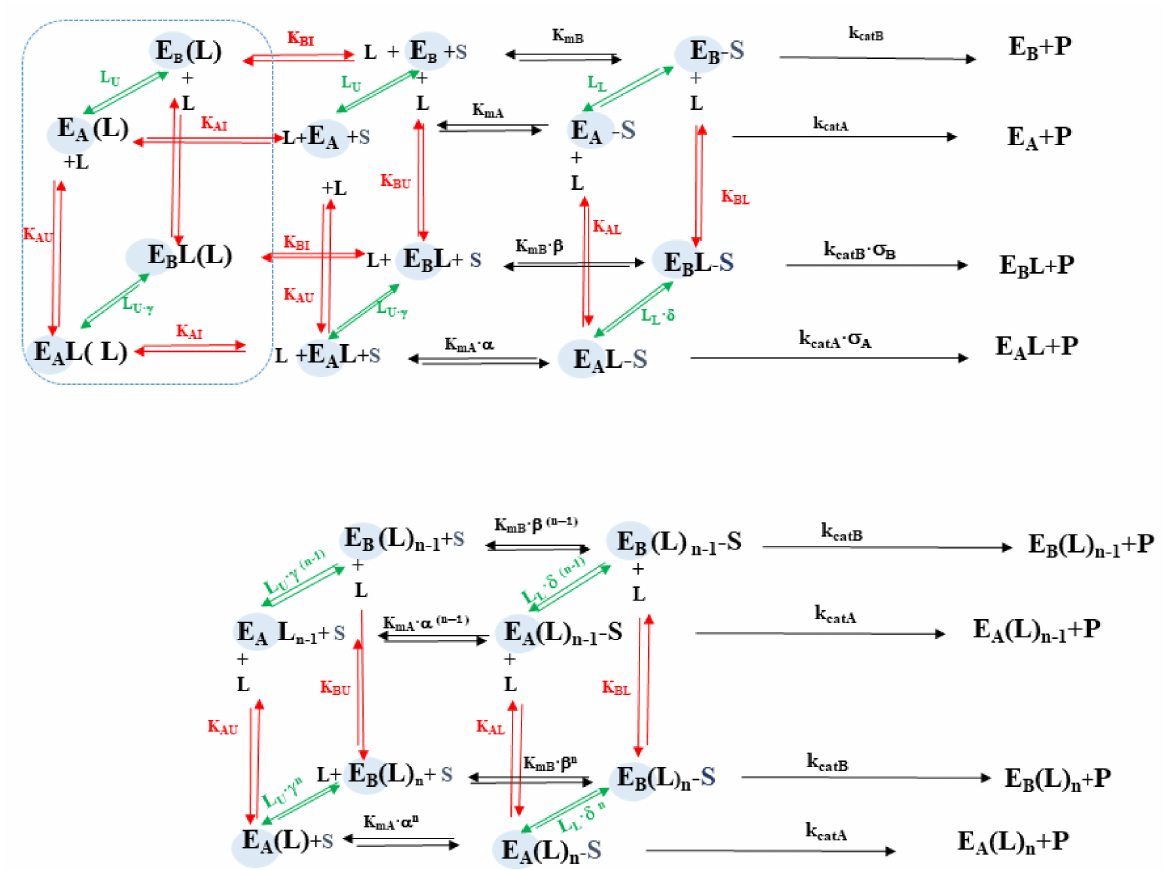
of h20S (E) on the substrate (S) by the porphyrin TMPC. In the upper part is the scheme for the first TMPC binding step, while in the lower part is the scheme for the last n-th TMPC binding step. The left cube (enclosed in the blue rectangle) concerns the binding of TMPC to the competitive inhibitory site, which, for the sake of clarity, is depicted only for the first binding step, but it may occur also at all intermediate bound degrees, concerning only the substrate-free enzyme. Parameters concerning the enzymatic activity are depicted in black, those regarding TMPC binding are depicted in red, and conformational equilibria are depicted in green. The meaning of various parameters is: k catA and k catB are the rates of the rate-limiting step in the two states A and B, K mA and K mB are the Michaelis–Menten constants in A and B, K AU and K BU are the affinity constant for TMPC of the 20S proteasome in the absence of substrate in the two states A and B, K AL and K BL are the affinity constant for TMPC of the 20S proteasome in the substrate-bound ES complex, while K AI and K BI are the affinity constant for TMPC to the inhibitory competitive site of the 20S proteasome. L U is the equilibrium constant between A and B in the absence of the substrate, L L is the equilibrium constant between A and B in the substrate-bound ES complex, and “n” is the interaction parameter, which reflects the minimum number of porphyrin units binding cooperatively to their site on